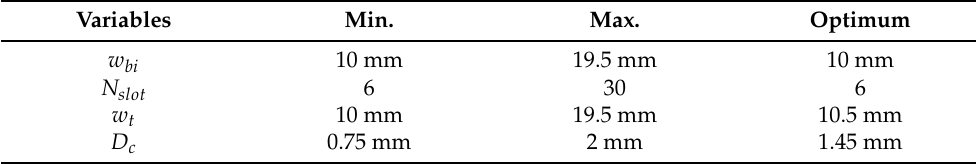
Table 8. Optimum, lower, and upper bounds of the optimization variables.